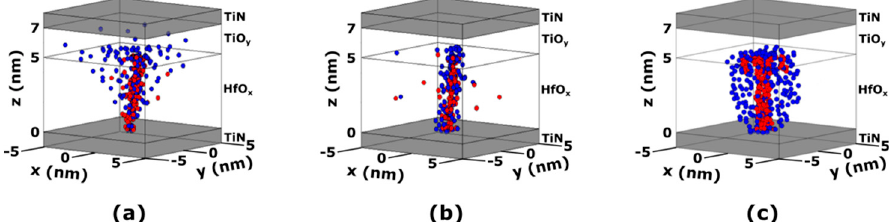
Figure 6. Simulated distributions of the oxygen ions (blue) and vacancies (red) in TiN/5 nm HfO x /TiO y /TiN RRAM stacks after forming with a ( a ) constant voltage, ( b ) ramped voltage, and ( c ) pulsed voltage. The forming process was performed using a 1 µA compliance current and 25 °C external temperature.